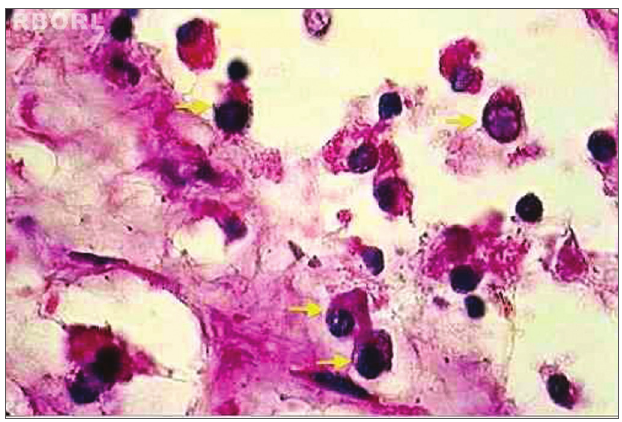
Figura 2. Histopatologia de pólipo nasossinusal eosinofílico tratado com mitomicina C e incubado por 12 horas (H&E. 1000x). É possível identificar alterações compatíveis com apoptose eosinofílica na maioria das células (setas amarelas).